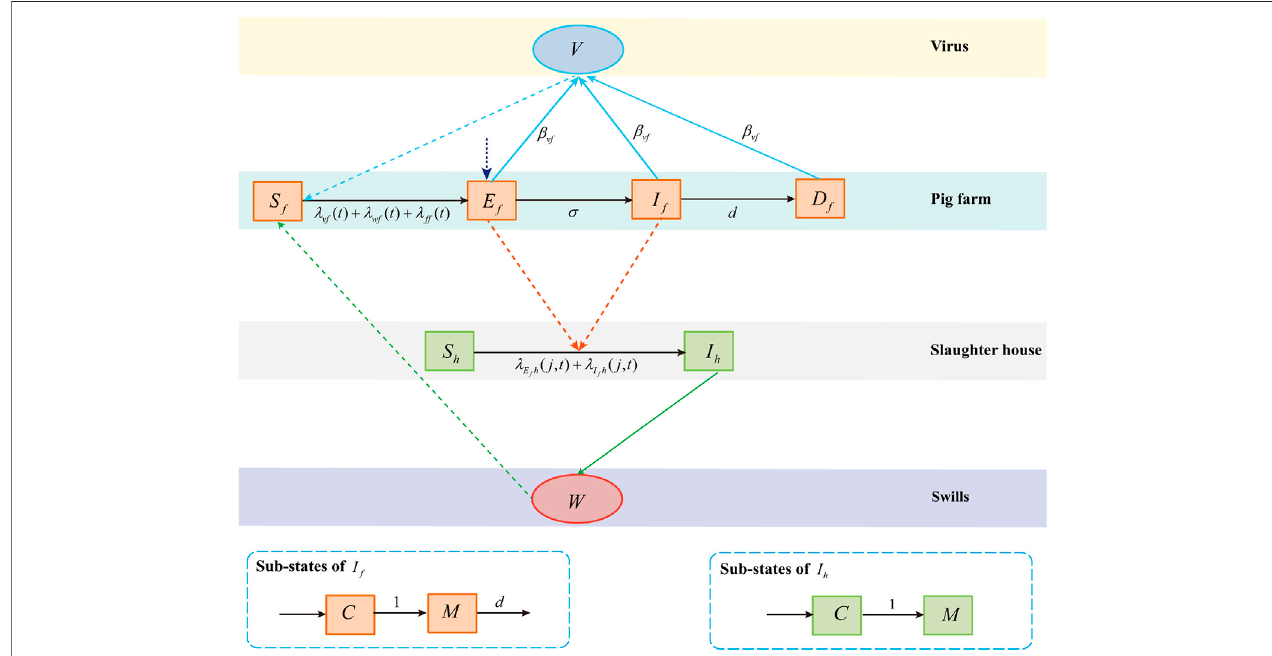
FIGURE 4 | State transition of nodes in the ASFV transmission model.